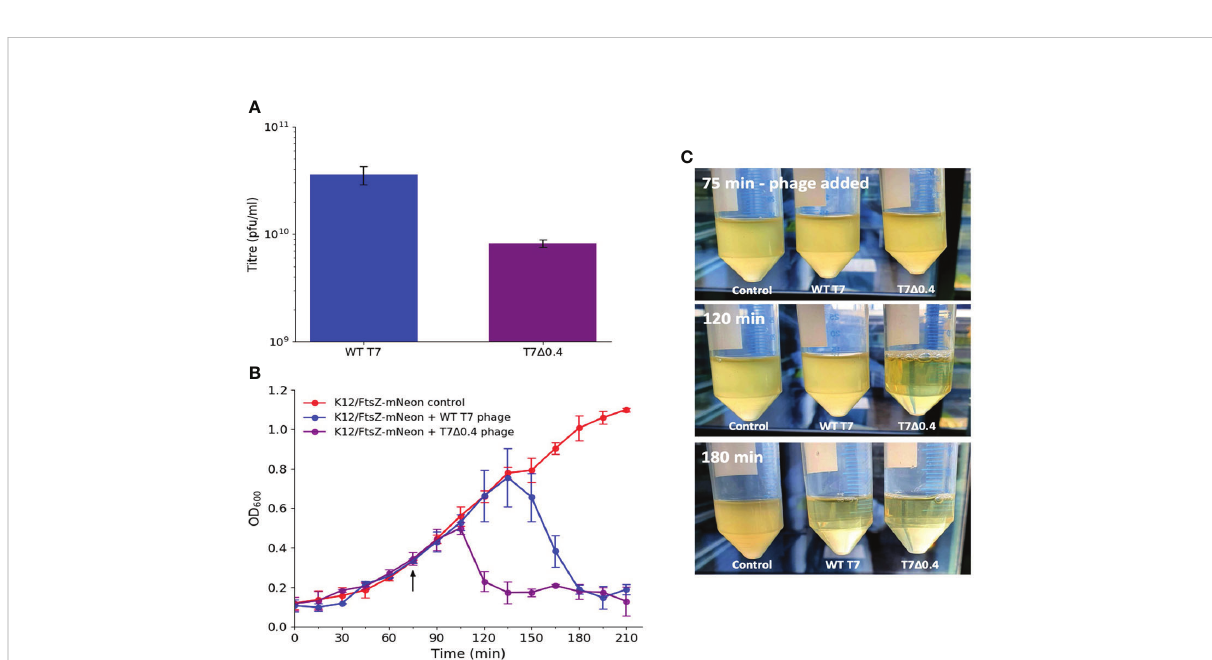
FIGURE 7 T7 D 0.4 mutant experiments showing that gp0.4 delays lysis and increases progeny. (A) WT T7 and T7 D 0.4 phages were propagated and titred by plaque assays in triplicate. Averages plotted on a log scale with error bars showing one standard deviation of uncertainty. (B) Growth curves were performed on cultures of K12/FtsZ-mNeon only, K12/FtsZ-mNeon and WT T7, K12/FtsZ-mNeon, and T7 D 0.4 phage. Average readings across replicates at 15-min time intervals were plotted with error bars showing one standard deviation unit of uncertainty. Arrow shows when phage was added. (C) Photo time series of growth curves with images of cultures taken upon phage addition at 75 min, at 120 min showing T7 D 0.4 lysis, and 180 min showing WT T7